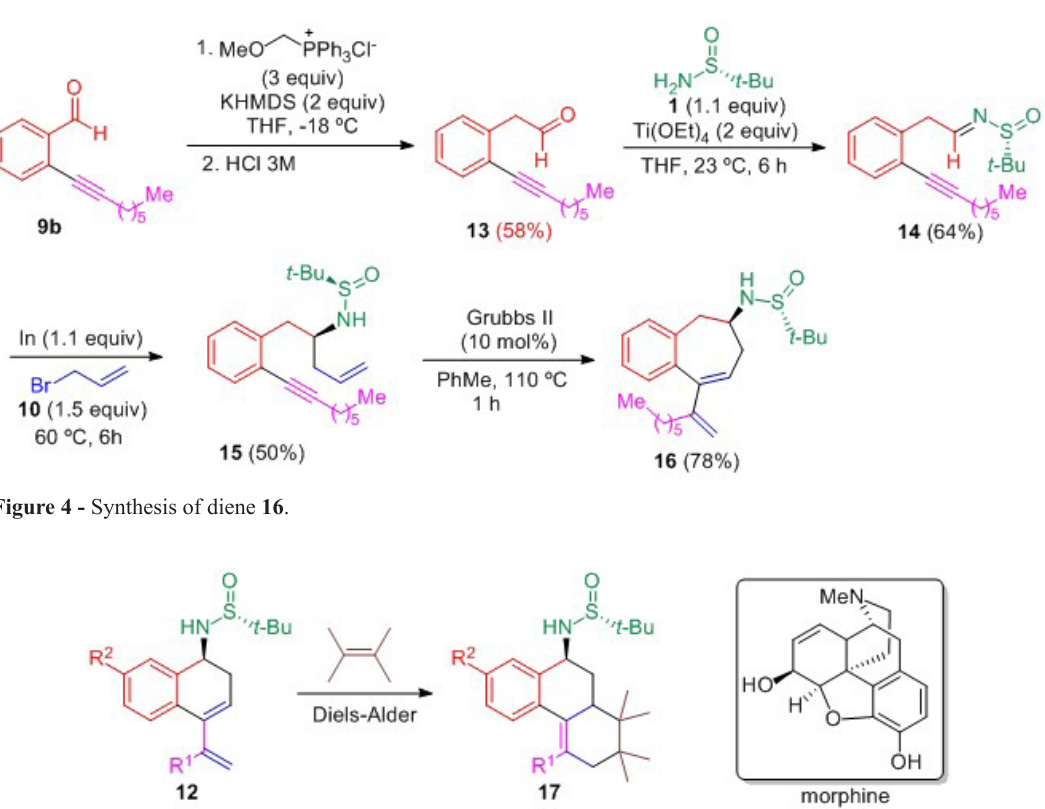
Figure 5 - Potential synthetic applications of dienes 12